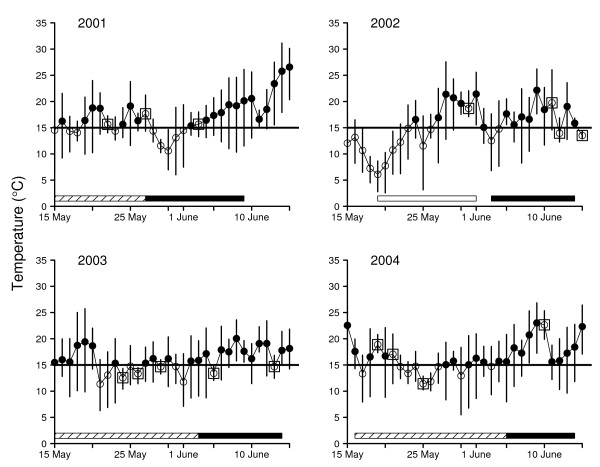
Mean hourly temperatures (± maximum and minimum temperatures for the foraging period 0400 h to 1900 h) during the emergence and approximate flight period of Enallagma boreale for the years 2001–2004 at Jack's Marsh. Closed circles represent good days of weather while open symbols represent poor weather. Bouts of poor weather were considered to be at least two consecutive days of poor weather. The line marked at 15°C indicates the cut off for our measure of poor weather and open squares indicate days with > 5 mm of rain, also indicating poor weather. The open bar represents the period of time when newly emerged individuals were observed and/or collected at Jack's Marsh. Open bar with hatch marks represents an estimated period of time when newly emerged individuals would likely have been observed at Jack's Marsh (reproductive maturity takes approximately 10–12 d to occur). The closed bar represents the period of time when mature adults were collected at Jack's Marsh.